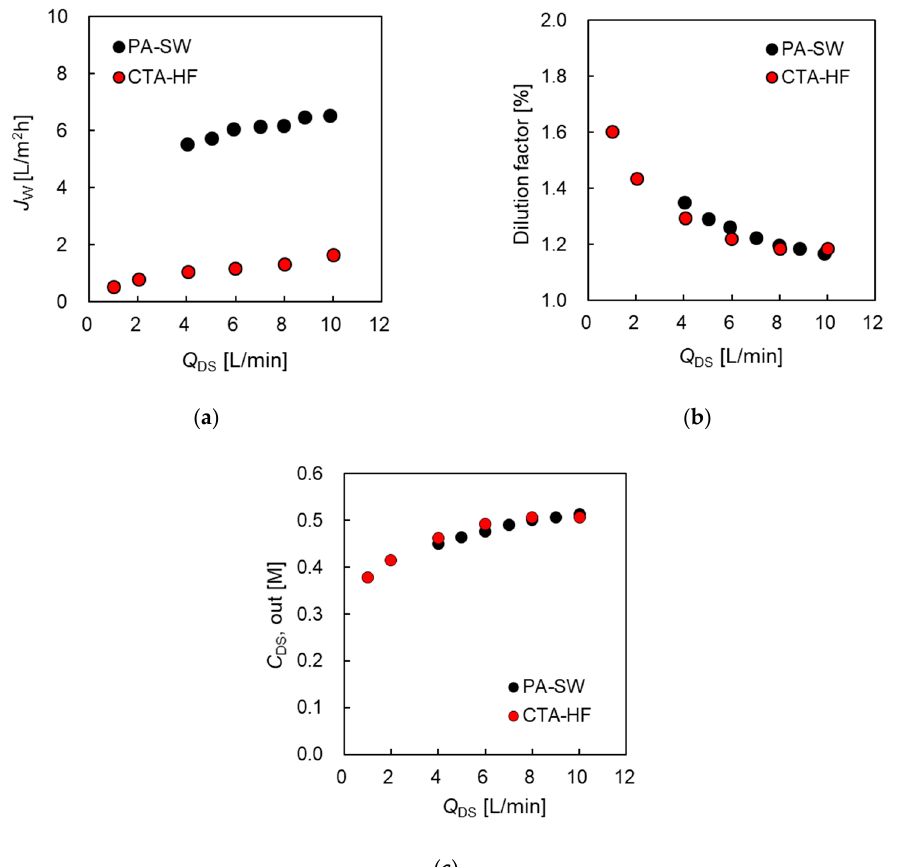
Figure 6. ( a ) Water flux, J w , and ( b ) dilution factor, ϕ , and ( c ) the concentration of the module outlet at DS side ( C DS,out ), respectively, as a function of DS flow rate, Q DS . DS: 0.6 M NaCl. FS: treated tap water. Q FS : 5.0 L/min. Δ P : 1.2 MPa.